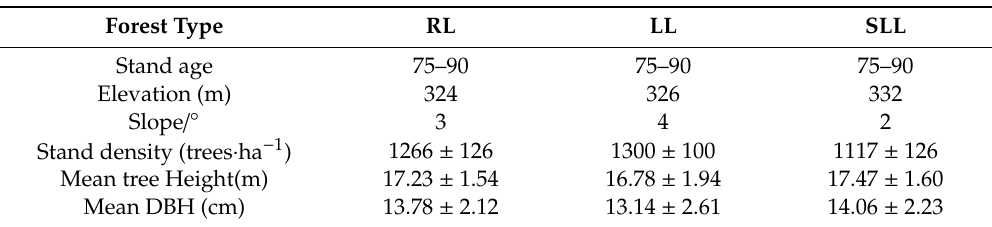
Table 1. Stand characteristics of the three typical larch forest ecosystems in the Daxing’an Mountains forest region. DBH: diameter at breast